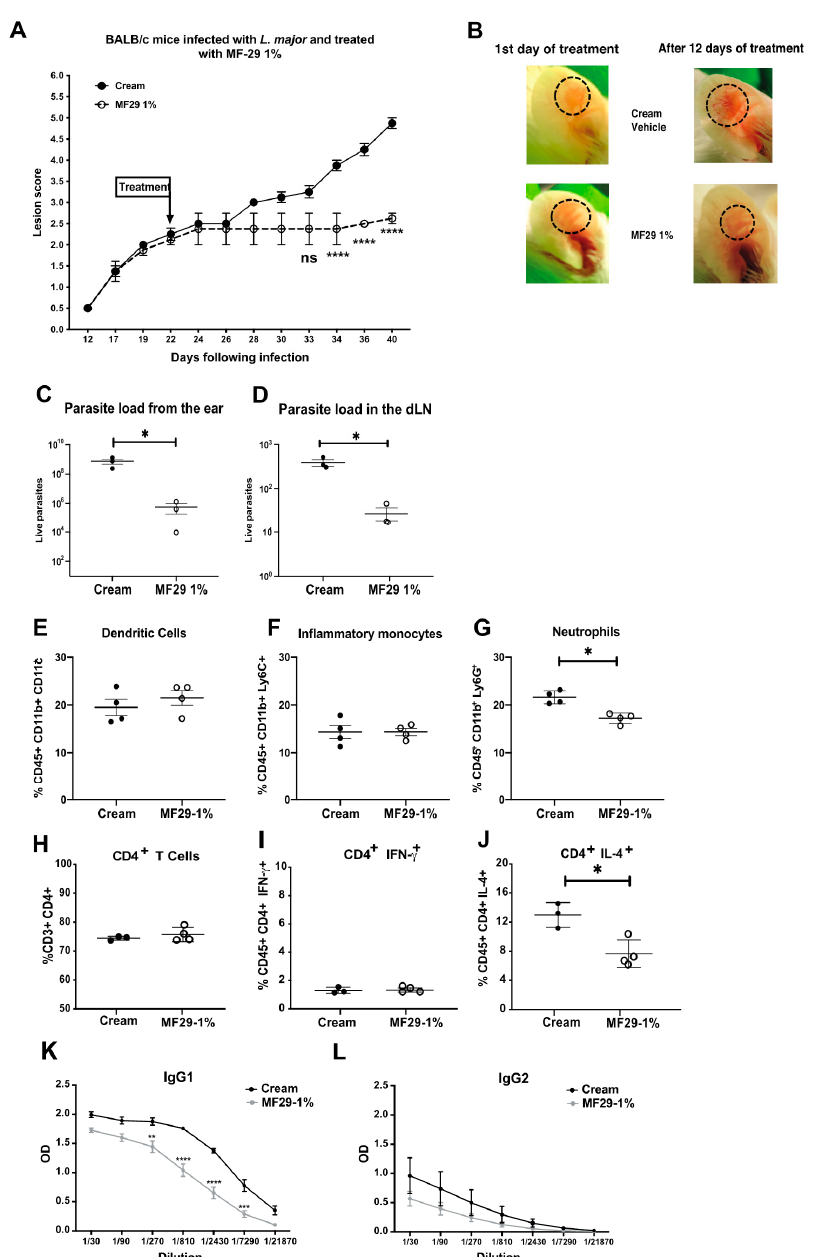
Figure 3. Topical treatment with MF29 1% decreases cutaneous pathology. BALB / c mice were infected i.d. with metacyclic L. major LV39 promastigotes and ears were treated once daily with either vehicle cream or with MF29 1% cream once the lesion score reached 2. ( A ) Lesion score following infection. Data are mean ± SEM, Two-Way ANOVA (Bonferroni’s post-hoc test) * p < 0.05, **** p < 0.0001, ns = not significant. ( B ) Representative pictures from an ear at the onset and after 12 days of treatment with vehicle cream and MF29 1% topical cream. ( C ) Forty days post-infection, the parasite load was determined in infected ears and ( D ) draining lymph nodes. ( E ) The frequency of monocyte-derived dendritic cells, ( F ) inflammatory monocytes, and ( G ) neutrophils was also determined. The frequency of dLN ( H ) CD4 + T cells, ( I ) CD4 + INF- γ + and ( J ) CD4 + IL-4 + was determined by flow cytometry. The data are represented as mean ± SEM, non-parametric T -test (Mann–Whitney U -test), ( K ) the relative amount of L. major -specific IgG1 and of ( L ) IgG2b present in the sera of mice was analyzed by ELISA, Data are mean ± SEM, Two-Way ANOVA (Bonferroni’s post-hoc test) ** p < 0.005, *** p < 0.0005, **** p < 0.0001. The data are representative of three experiments with ≥ 4 mice / group. * p <